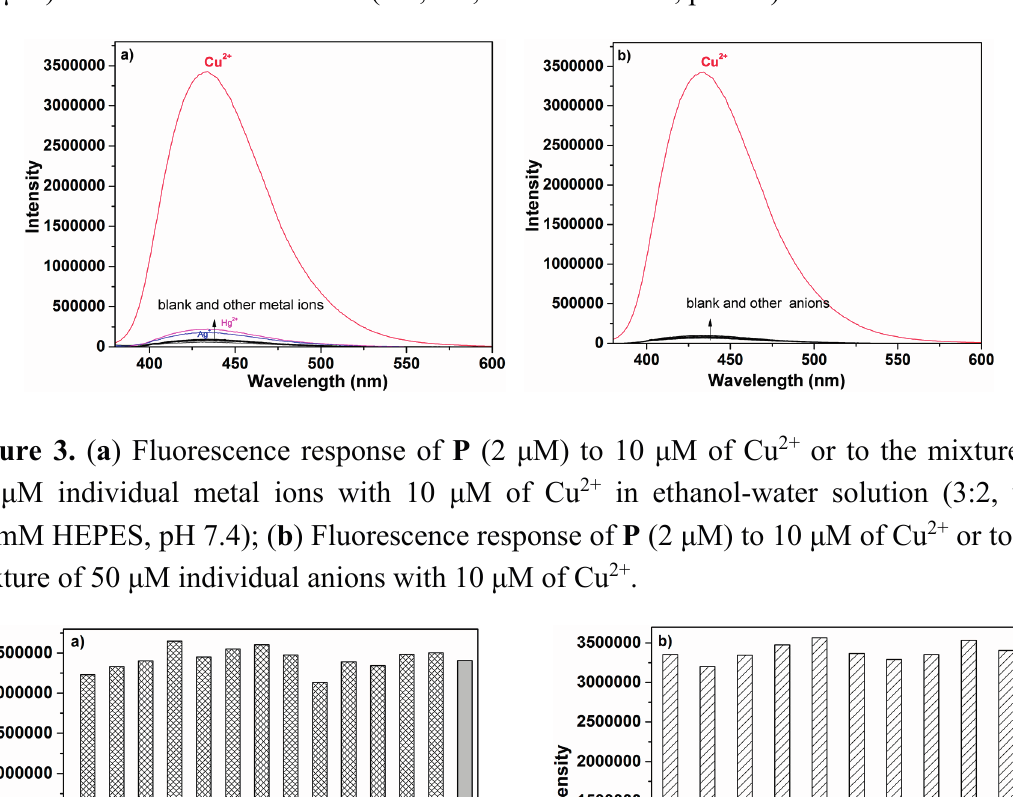
Figure 2. ( a ) Fluorescence spectra of P (2 μ M) with different metal ions or ( b ) anions (50 μ M) in ethanol-water solution (3:2, v:v, 50 mM HEPES, pH 7.4).